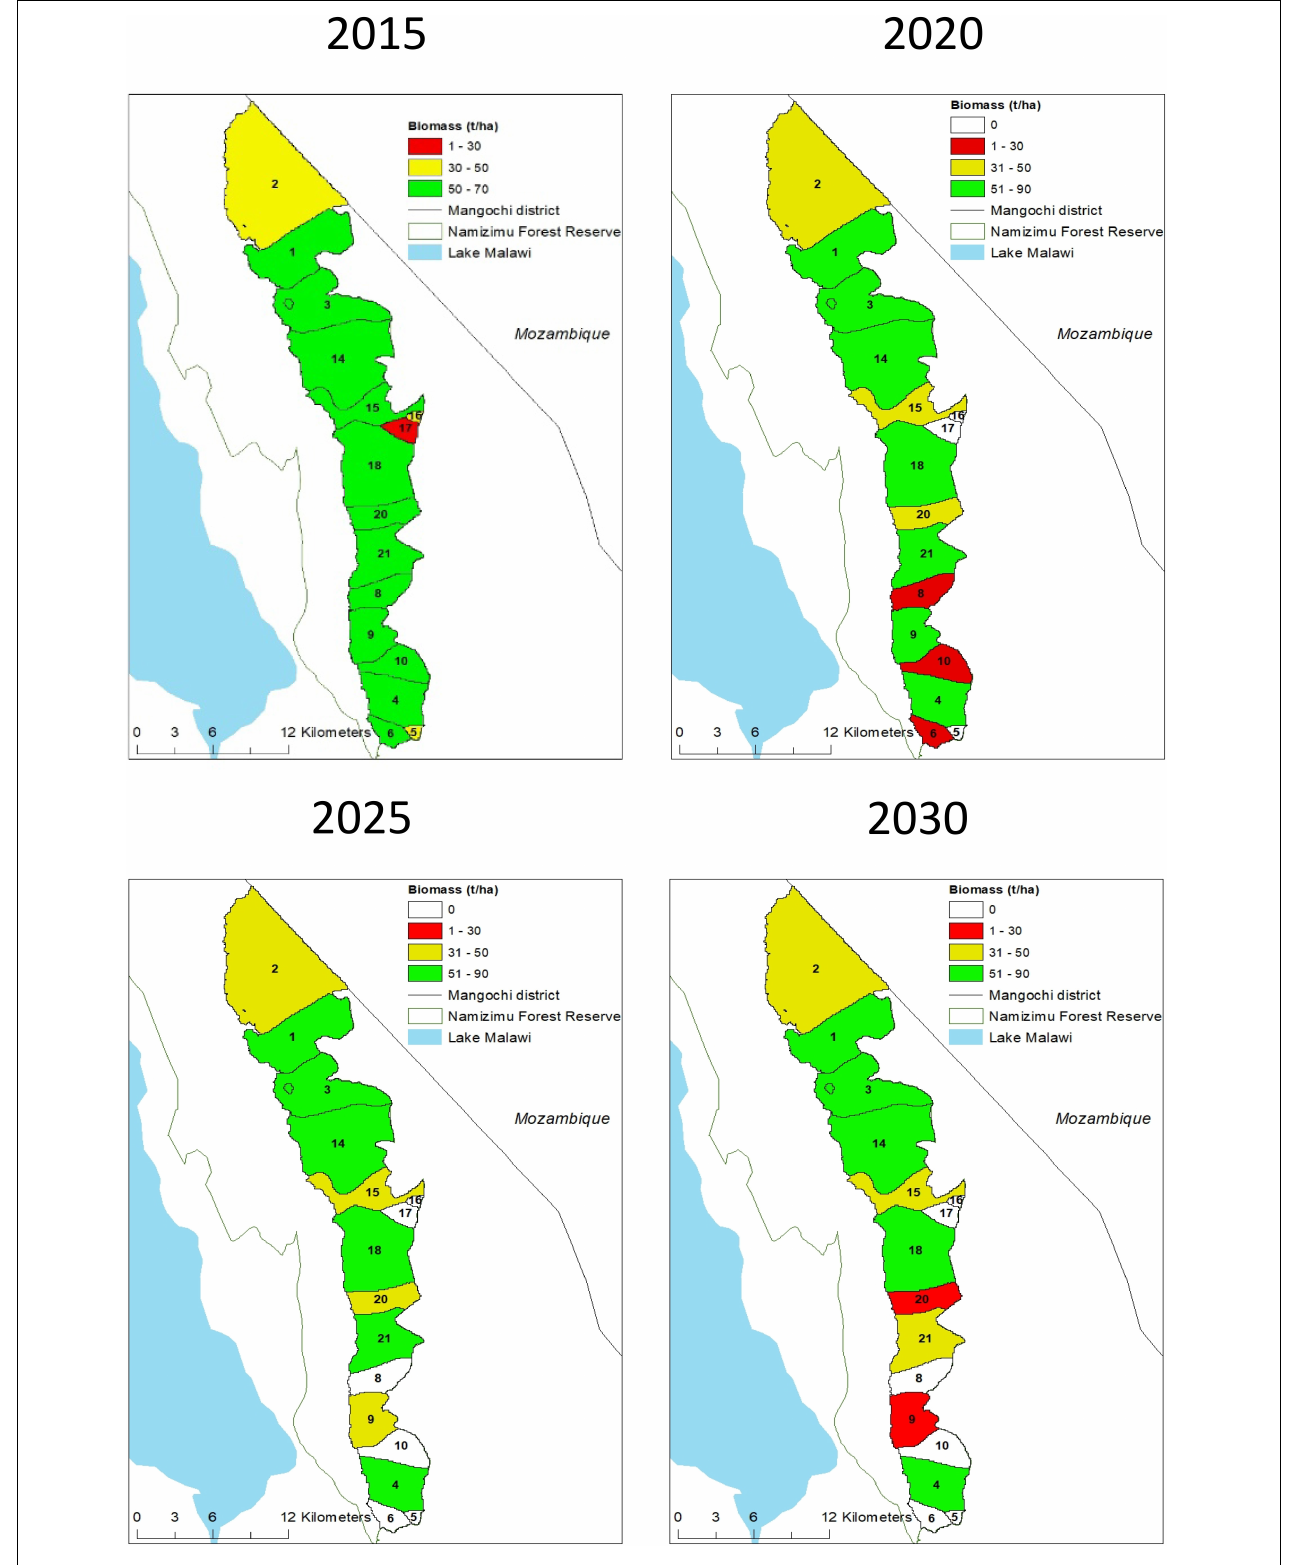
FIGURE 3 | Scenario analysis [business as usual (BAU)].